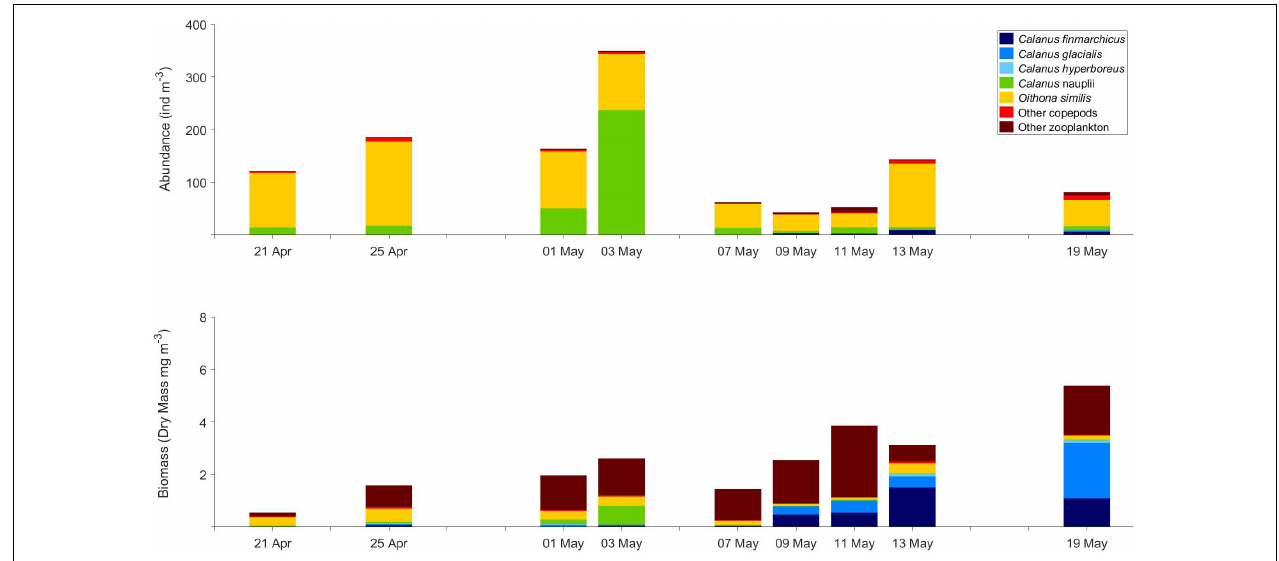
FIGURE 4 | Abundance (ind. m − 3 ) and biomass (dry mass, mg m − 3 ) of main zooplankton taxa in the upper 5 m below the ice, collected with swim nets by scuba divers, from 21 April to 19 May 2015.